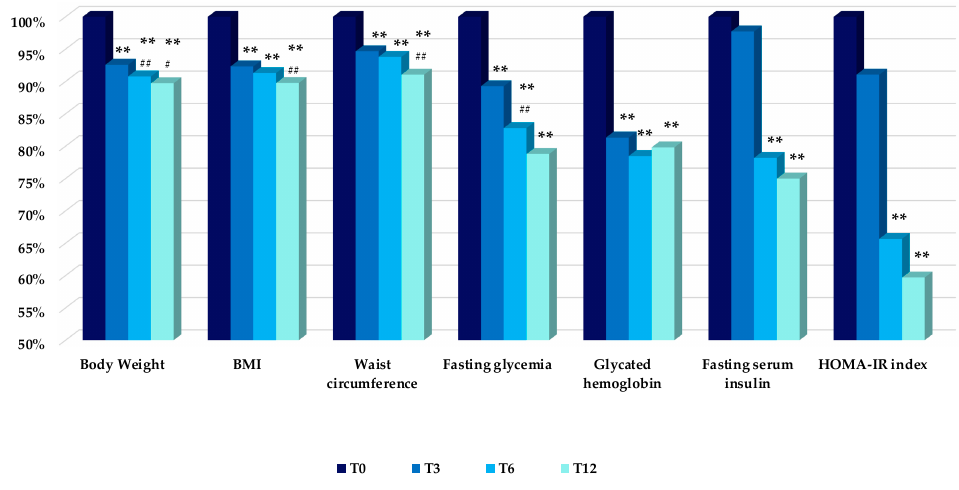
Figure 4. Values are expressed as a percentage of changes in anthropometric (Body Weight, BMI, Waist Circumference), and glucometabolic (Fasting Glycemia, Glycated Hemoglobin, Fasting Serum Insulin, and HOMA-IR index) parameters compared to the baseline (T0 = 100%). Changes versus T0: ** p < 0.01. Changes versus former time: # p < 0.05; ## p < 0.01. Abbreviations: BMI = Body Mass Index; HOMA-IR = homeostasis model assessment of insulin resistance.